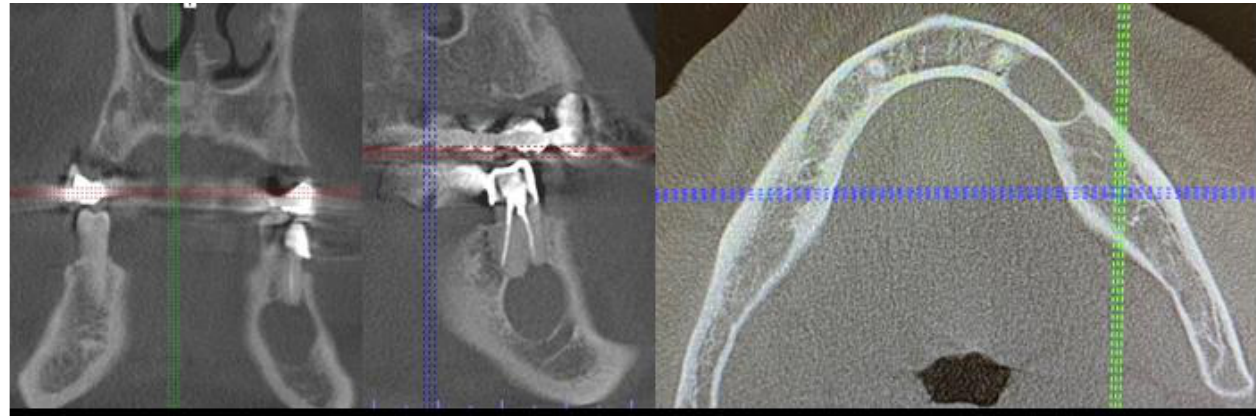
Figure 5. Intraoral photograph with granulation tissues arising from under the dental bridge.